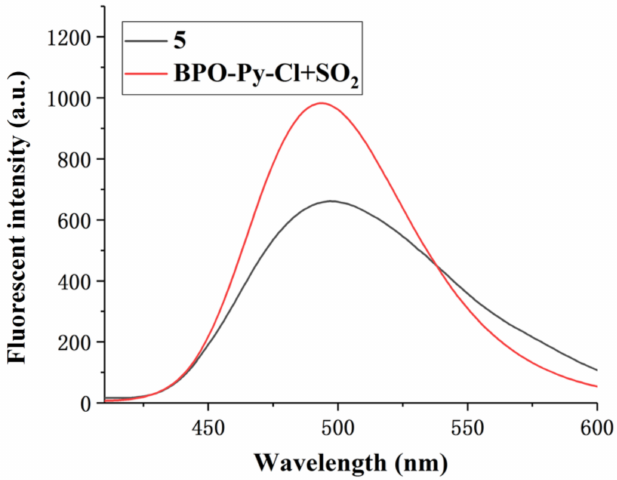
Figure 6. The fluorescent spectrum of compound 5 and BPO-Py-Cl interacting with SO 2